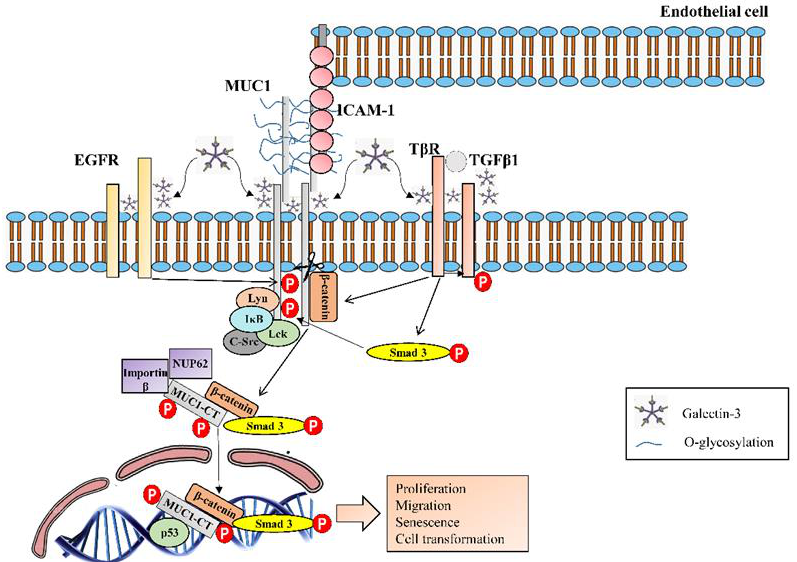
Figure 8. MUC1 activation and intracellular signalling. MUC1 is activated by extracellular ligands such as the intracellular adhesion molecule-1 (ICAM-1), which interacts with the protein component of the MUC1 VNTR or MUC1-N terminal domain. MUC1-C interacts with the galectin 3 ligand, which functions as a bridge to associate MUC1-C with di ff erent growth factor receptors at the cell surface as for example epidermal growth factor receptor (EGFR), which can activate and phosphorylate MUC1-CT. For the transforming growth factor β 1 (TGF β 1) receptor (T β R), galectin-3 stabilizates it, so galectin-3 could serve also as a bridge between MUC1-C and T β R. Moreover, it has been hypothesized that through Smad3 phosphorylation, induced by T β R activation, MUC1-CT is phosphorylated and translocated into the nucleus. Furthermore, TGF β 1 is also able to activate and induce nuclear localization of the fibrotic transcription factor β -catenin. A nuclear protein complex constituted by MUC1-CT / phospho (p)-Smad3 and β –catenin is formed and it promotes fibrotic processes such as epithelial to mesenchymal transition (EMT) and fibroblast to mesenchymal transition (FMT). MUC1-CT can also directly interact with intracellular kinases such as c-Src, Lyn and Lck or I κ B kinase complex, which also activate and phosphorylate MUC1-CT. Phosphorylated MUC1-CT interacts with importin- β and with nucleoporin p62 (Nup62) to migrate into the nucleus. Once in the nucleus, MUC1-CT forms also nuclear complexes with other proteins as for example p53 and mediates IPF-linked processes such as proliferation, migration, cell senescence and cell transformation.